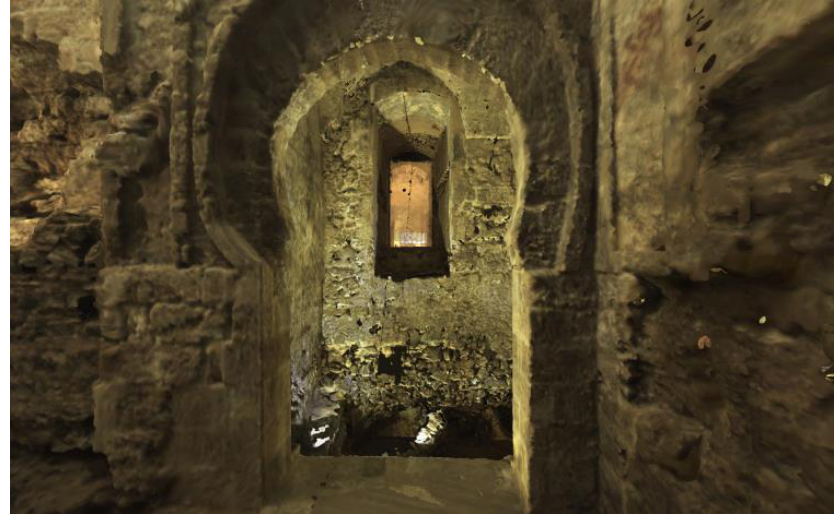
Figure 9. Interactive application.